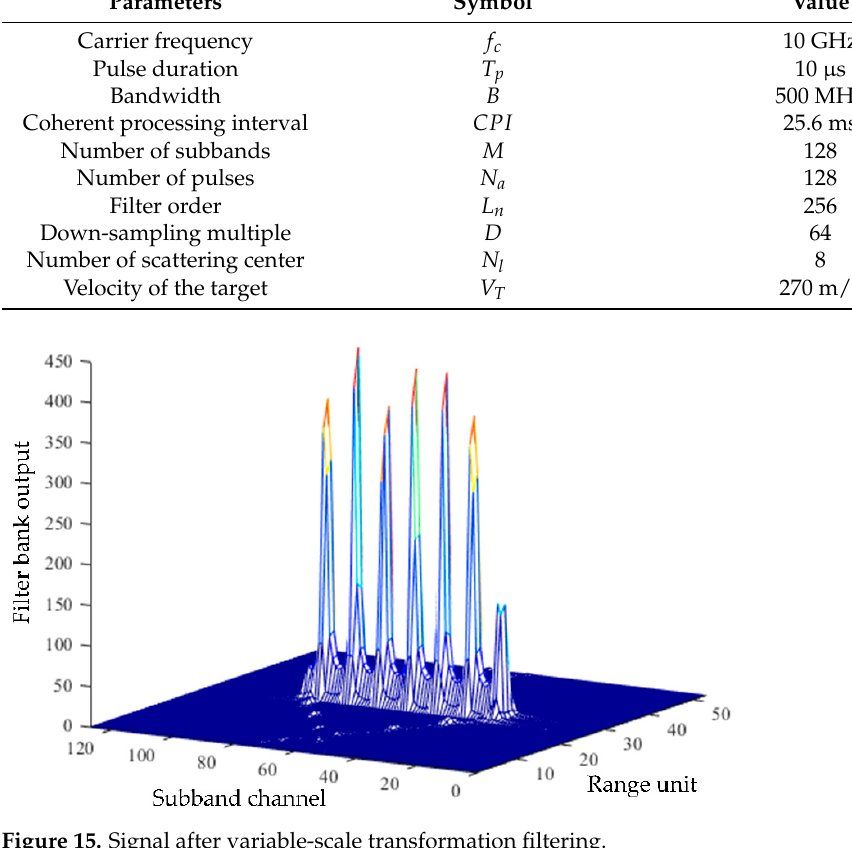
Figure 16. VSMTD results with